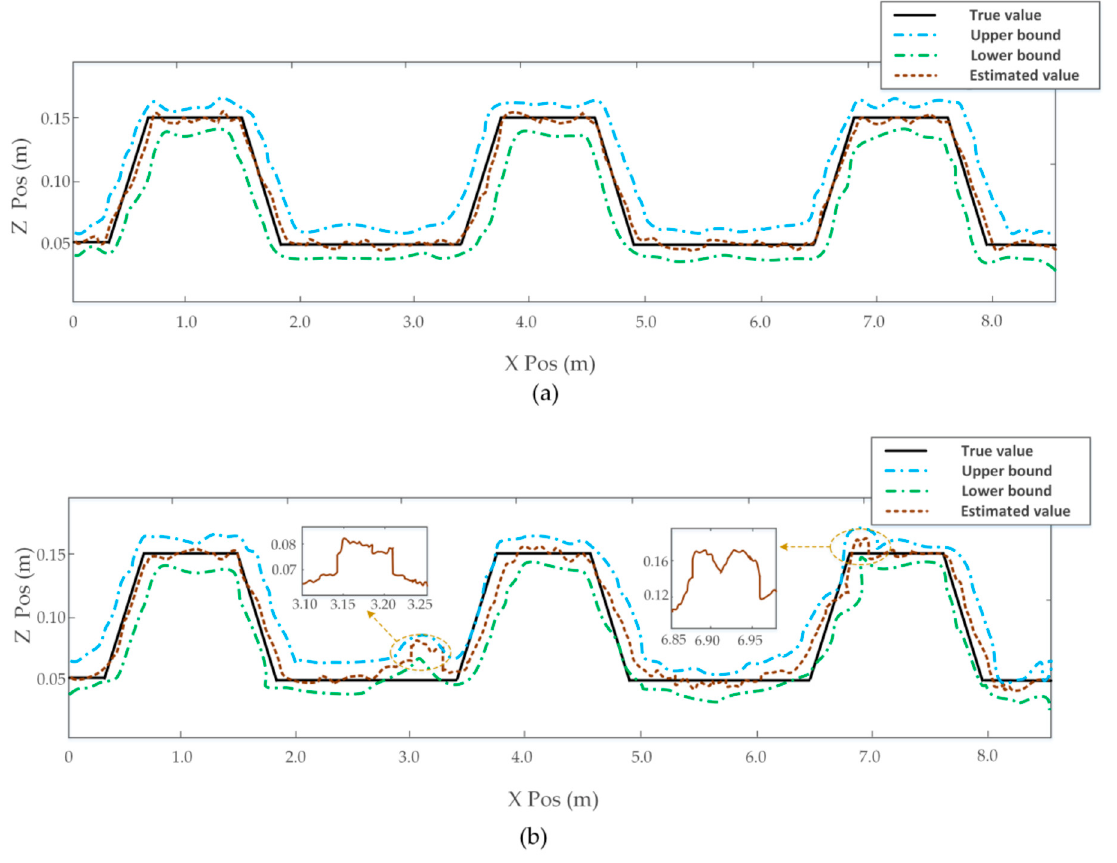
Figure 12. Estimated terrain elevation value. ( a ) Obtained data in active suspension mode. ( b ) Obtained data in passive suspension mode.